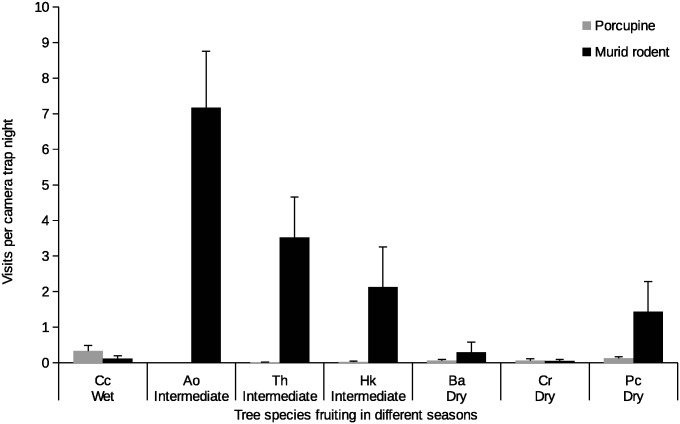
Rodent visitation rates on seed plots.Average number of visitations (± SE) by terrestrial rodents per camera trap night on experimental plots located in random forest sites for seven study tree species in different seasons. Sampling effort in terms of camera trap nights, total number of seeds sampled per species and total number of seed plots for tree species is: Ao–Actinodaphne obovata (8, 70, 3), Cc–Chisocheton cumingianus (58, 288, 6), Th–Talauma hodgsonii (58, 503, 7), Hk–Horsfieldia kingii (166, 386, 6), Pc–Prunus ceylanica (126, 299, 4), Cr–Canarium resiniferum (94, 501, 7), Ba–Beilschmiedia assamica (30, 183, 3).